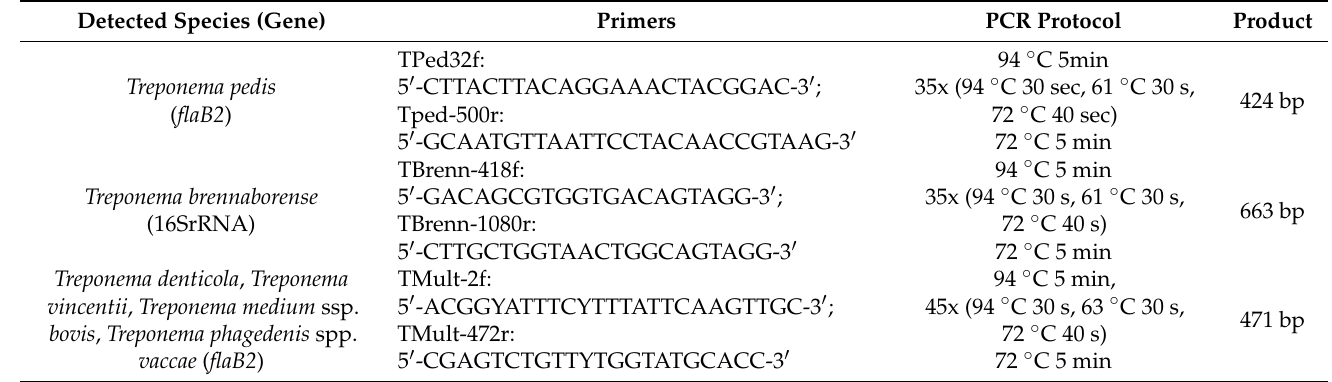
Table 1. PCR conditions for detection of Treponema